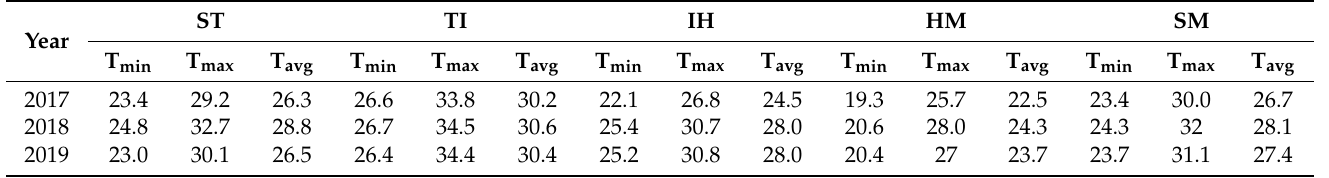
Table A4. The mean daily temperature (T avg , °C), minimum temperature (T min , °C) and maximum temperature (T max , °C) during different growth stages from 2017 to 2019.